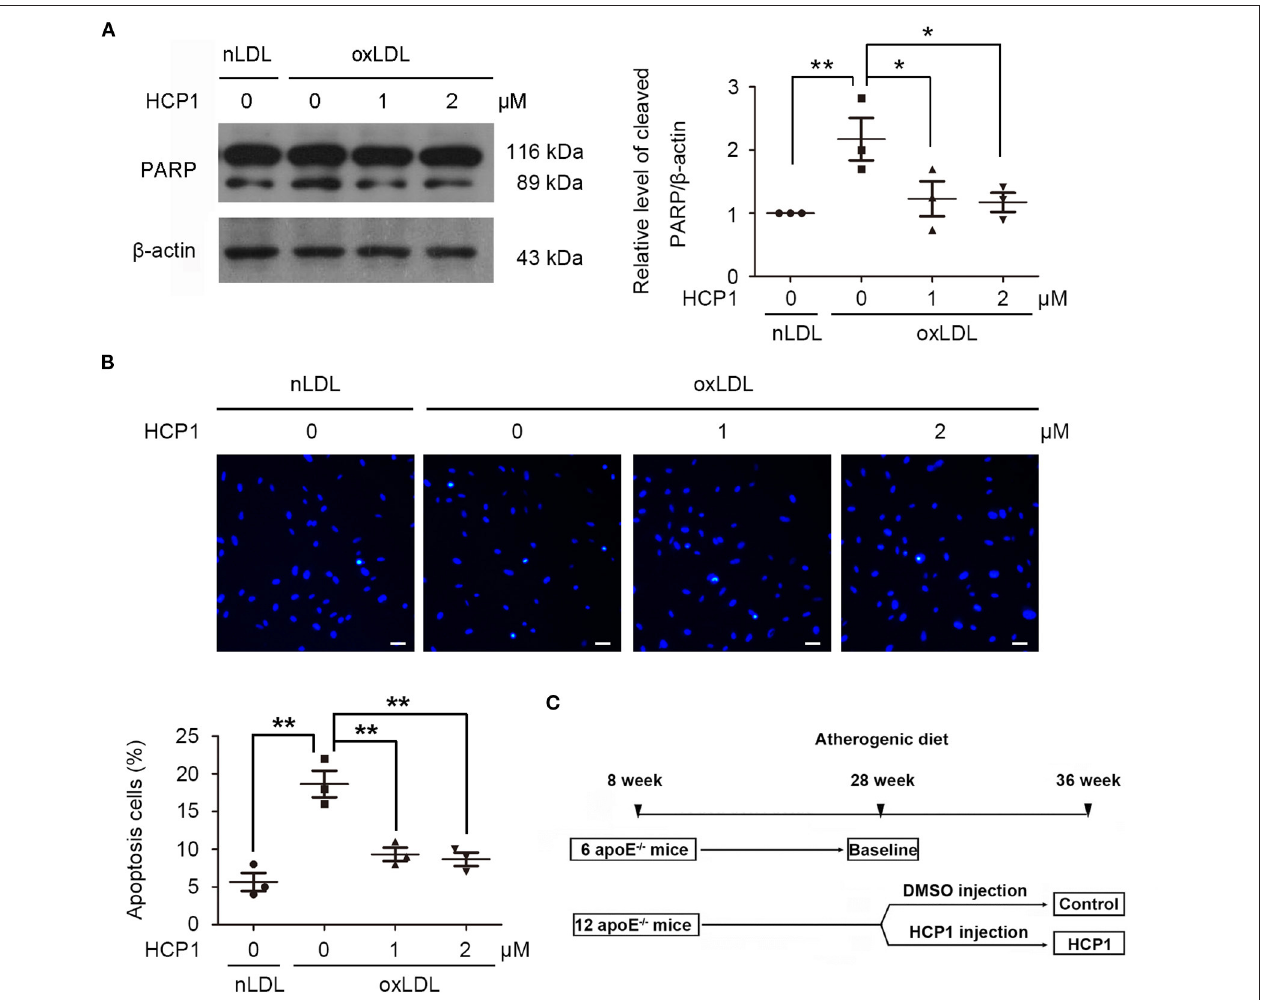
FIGURE 5 | HCP1 suppressed HUVEC apoptosis induced by oxLDL. (A) Protein levels of cleaved PARP were detected after treatment with nLDL (50 µ g/ml), oxLDL (50 µ g/ml) with or without HCP1 (1, 2 µ M) for 48h in HUVECs. (B) Hoechst 33258 staining and quantification of apoptotic HUVECs after treatment with nLDL (50 µ g/ml), oxLDL (50 µ g/ml) with or without HCP1 (1, 2 µ M) for 48h. Scale bar, 20 µ m. (C) Design of in vivo experiment. Eight-week-old apoE − / − mice were fed with an atherogenic diet for 20 weeks and randomized to three groups ( n = 6 mice/group) for treatment. The baseline group was euthanized. The HCP1 treatment group received 8 weeks’ intraperitoneal injections of HCP1 (1 mg/kg per day) and the control group was injected with the same volume of DMSO diluted with PBS. Data are mean ± SEM; * p < 0.05, ** p < 0.01; n = 3. Statistical analyses were performed using one-way